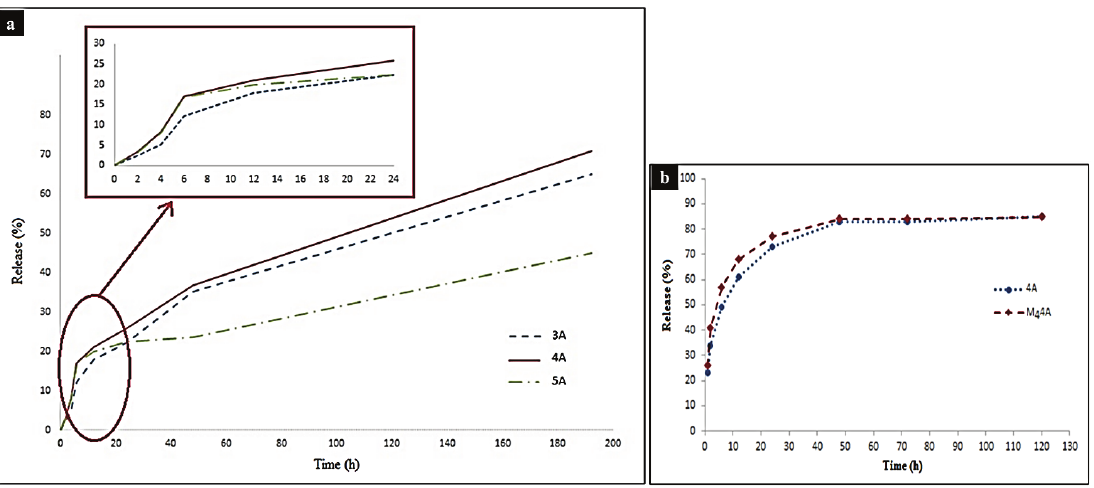
Figure 5: Release profiles of a) DOX